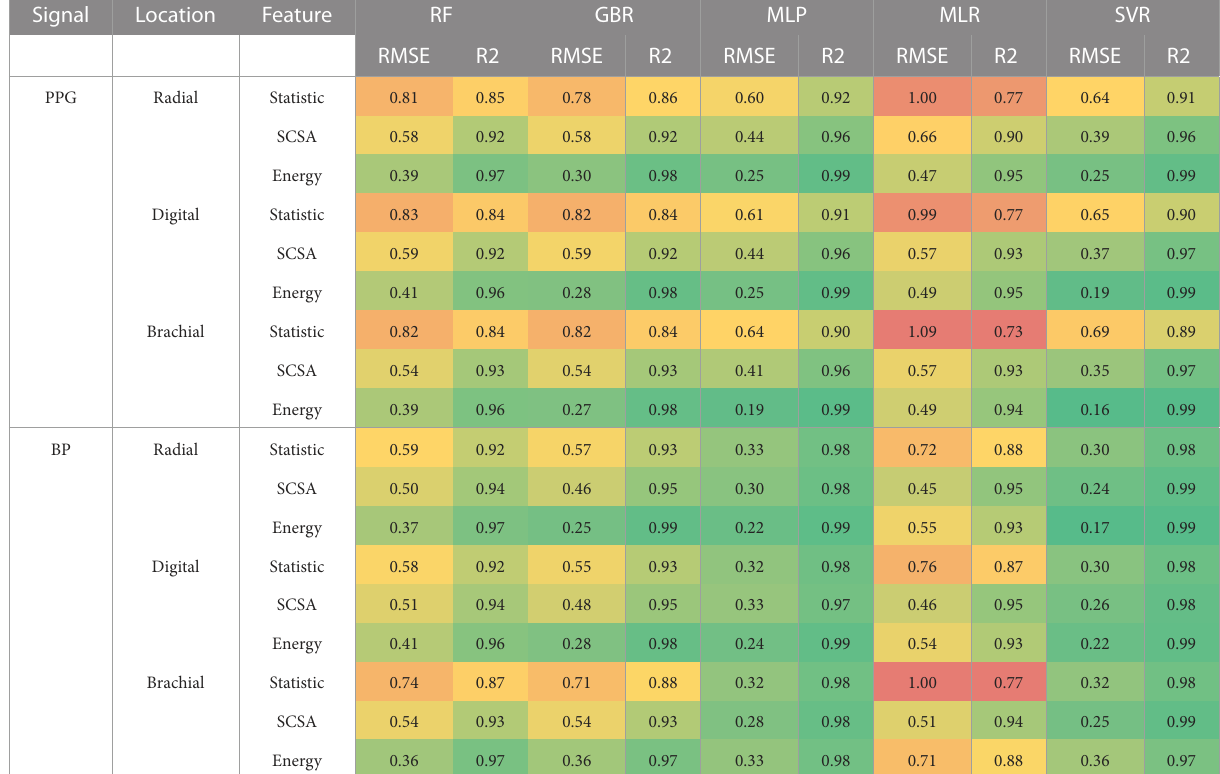
TABLE3 Free-noiseresultsobtainedforPPGandBPspectrogram. Signal